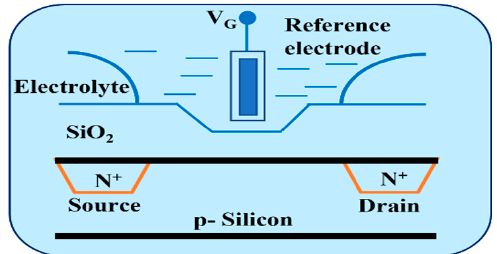
Figure 1. The structure of ISFET.